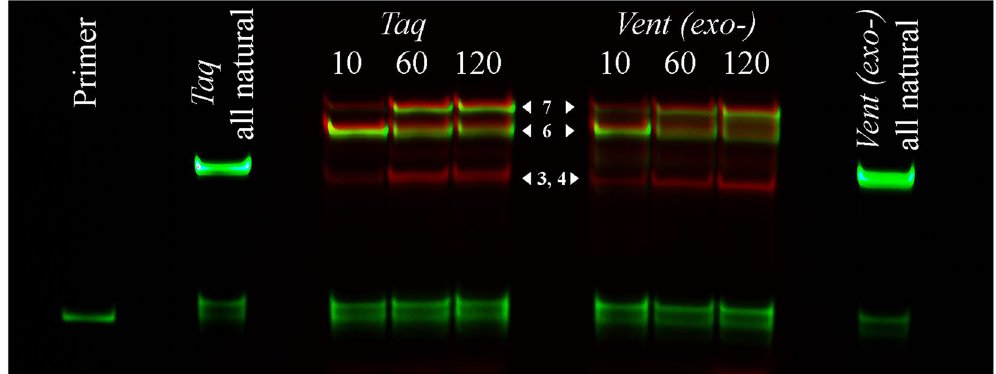
Figure 2. Dual channel overlay image of the gel-electrophoresis of the PE reaction in the presence of Taq and Vent (exo-) DNA polymerases at 72 °C. PE was performed either with all natural dNTPs for 10 min or using a mixture of dATP, dGTP, dCTP, and Y for varying amounts of time (10, 60, and 120 min). The concentration of the nucleotides was 200 μ M (each). Dual-labeled products (red-green bands) with different mobility accumulate in the reaction mixture over the course of the reaction because of Y incorporation. Cy5-labeled strands (red bands) appear over time in the reaction mixture due to modification of the template at the 3 ′ -end. Assignment of bands 3 (M-dT + Y), 4 (M + Y, M-dT + Y + dA, and M-dT + Y + dG), 6 (F), and 7 (F + Y) was made by comparative analysis of electrophoresis and MALDI data.